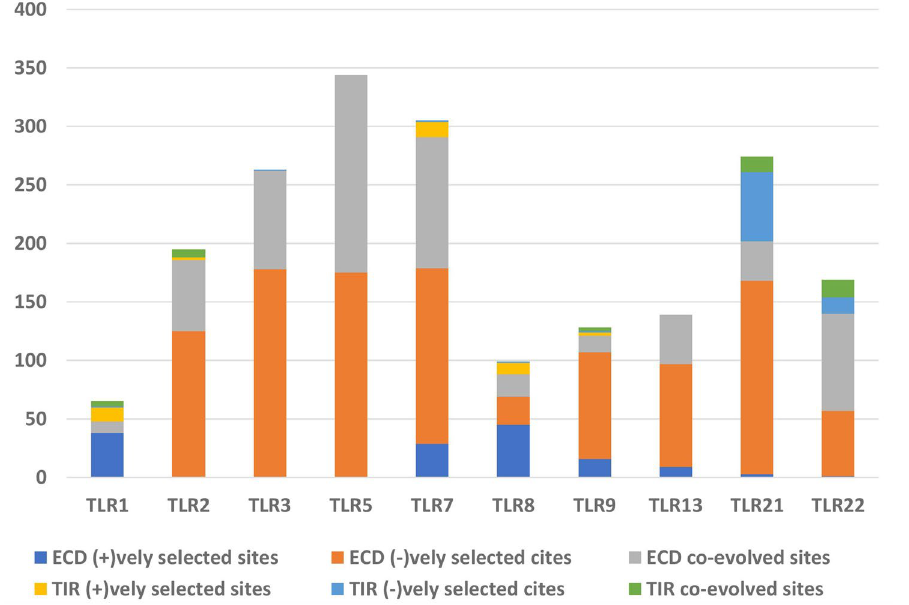
Figure 6. Graph depicting the localization of positively selected, negatively selected and co-evolved residues in the extracellular (ECD) and toll/interleukin-1 (TIR) domain of Clarias batrachus TLRs. The figure shows the localization of a higher number of positively selected sites to the extracellular domain (ECD) of TLR1, 7, 8 and 9, in comparison to their mapping on the Toll/Interleukin-1 receptor (TIR) domain. The ECDs of TLR2, 3, 5, 13, 21 and 22 are dominated by negatively selected and co-evolved